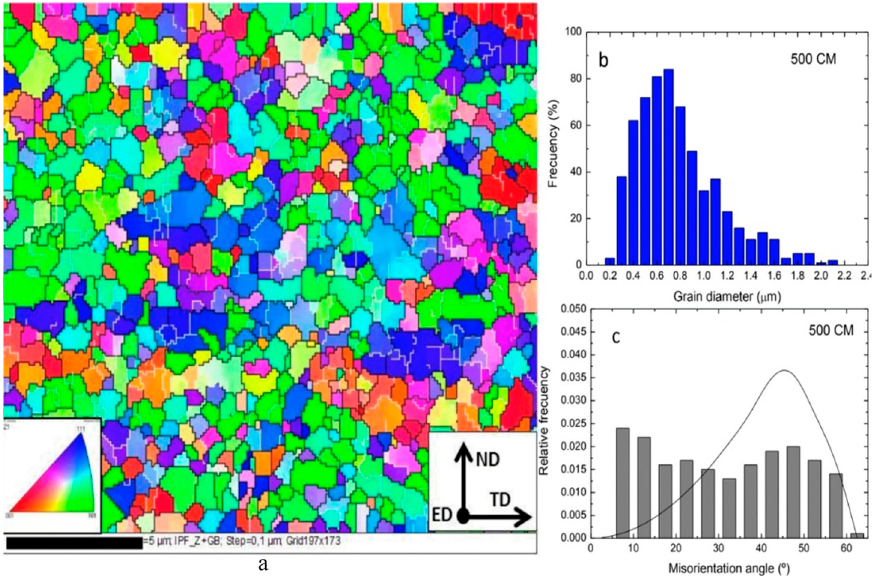
Figure 6. ( a ) Electron backscatter diffraction (EBSD) Crystal Orientation Map (COM) with inverse pole key for cubic materials inset in the bottom left corner, ( b ) grain size distribution histogram and ( c ) misorientation angle distribution histogram obtained from cross-sections of aluminium matrix of extruded profiles of unreinforced AA6005A-HEBM (high-energy ball milling) powder. Different colours reflect the crystal lattice orientation positions in the Euler space. Low-angle grain boundaries (LAGBs) and high-angle grain boundaries (HAGBs) are denoted by white and black lines, respectively.